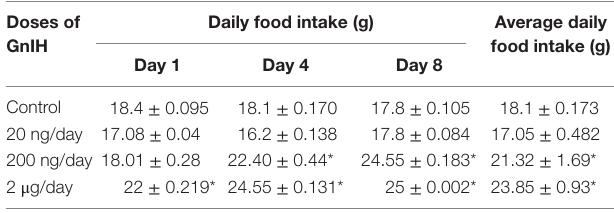
Values are mean ± SEM for five animals (daily food intake). *Significantly different from controls (p < 0.05) by one-way analysis of variance (ANOVA) followed by Bonferroni’s